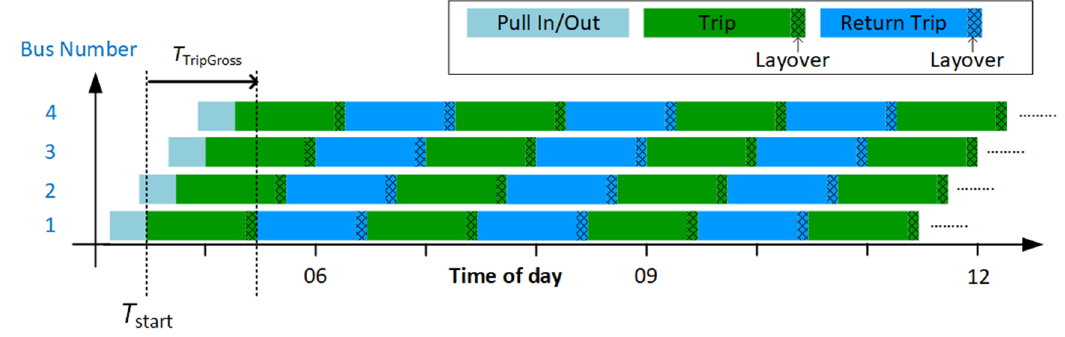
Figure 4. Example of buses needed to drive the trips during early morning traffic.